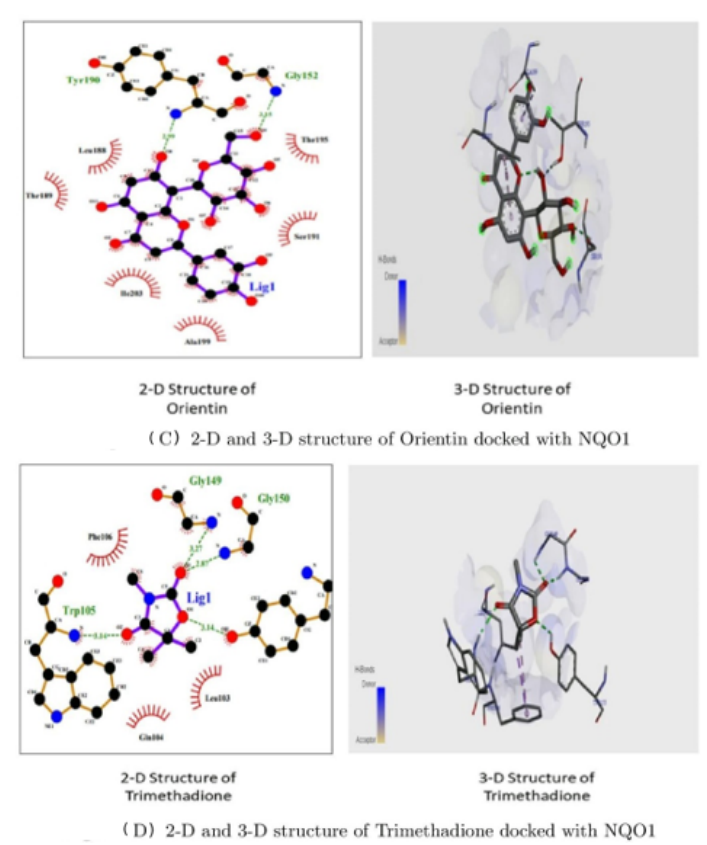
Figure 11. 2-D and 3-D structures of several phytobioactives docked with